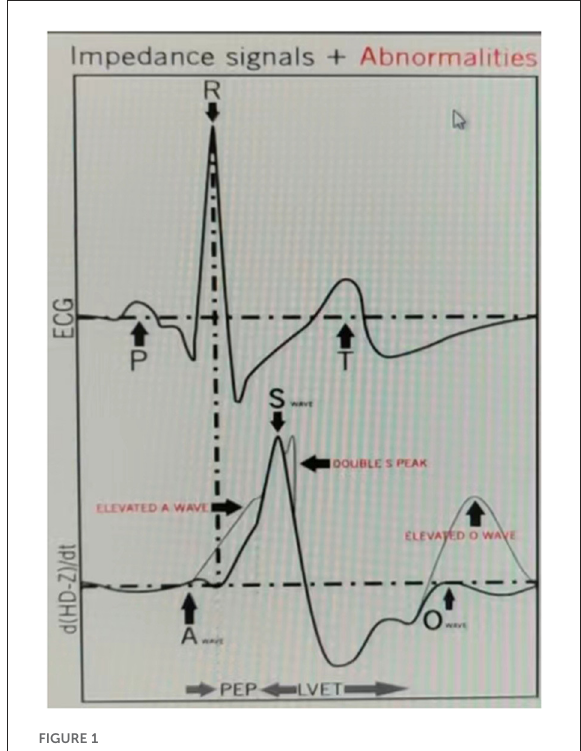
FIGURE1 Impedance signals and the position of the A, S, and O wave.